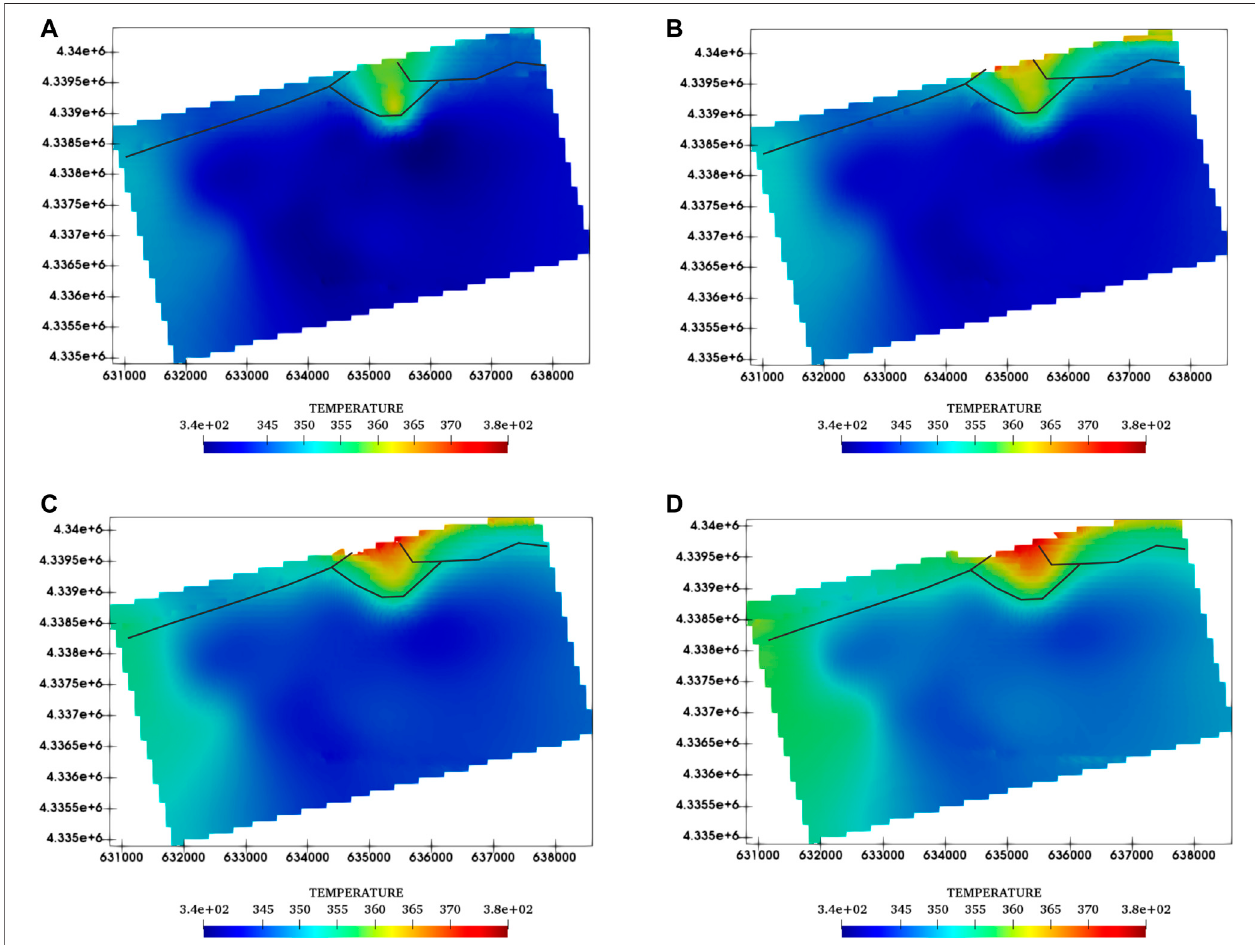
FIGURE 9 | 2D pro fi les of temperature (K) distribution at different depths. (A) 2,000 m, (B) 2,100 m, (C) 2,200 m, and (D) 2,300 m.